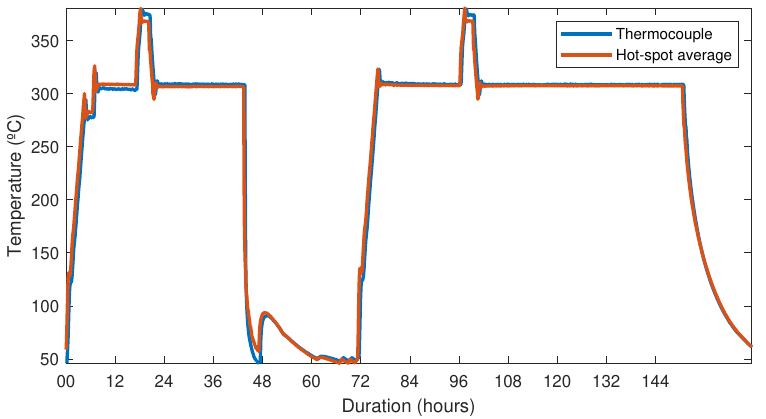
Figure 9. Comparison between the values recorded by the thermocouple and the average of the hot-spot